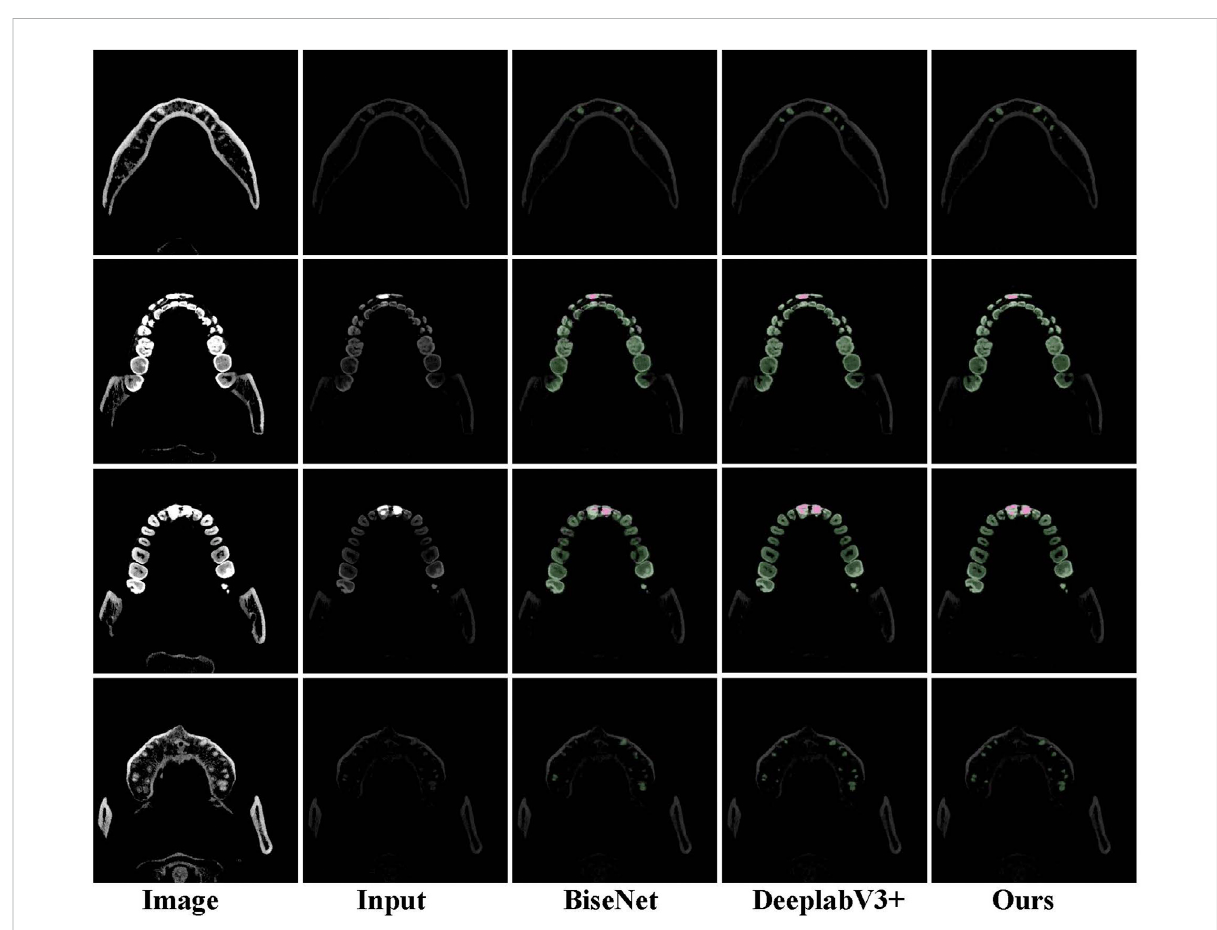
FIGURE 5 Examples of tooth segmentation are predicted by our method with other state-of-the-art